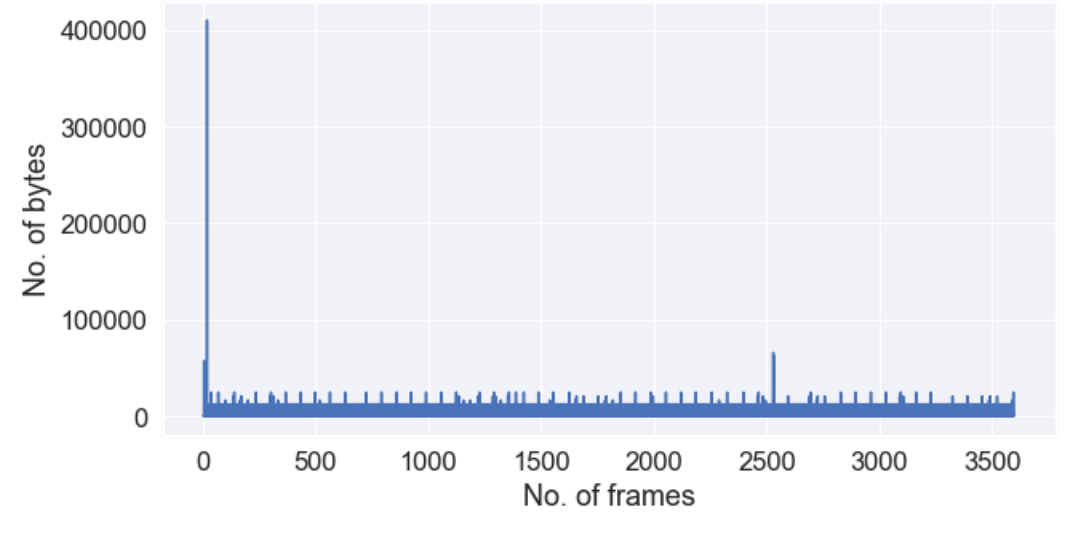
Figure 30b. Disk writes in S2.5.